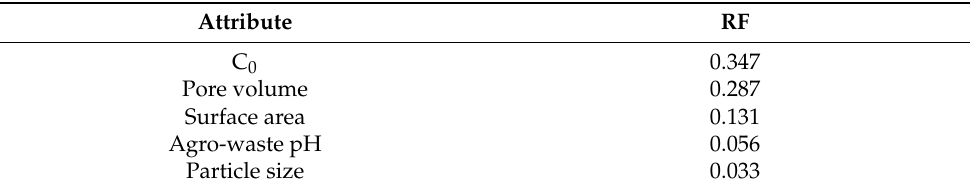
Table 6. Importance of variables based on RF